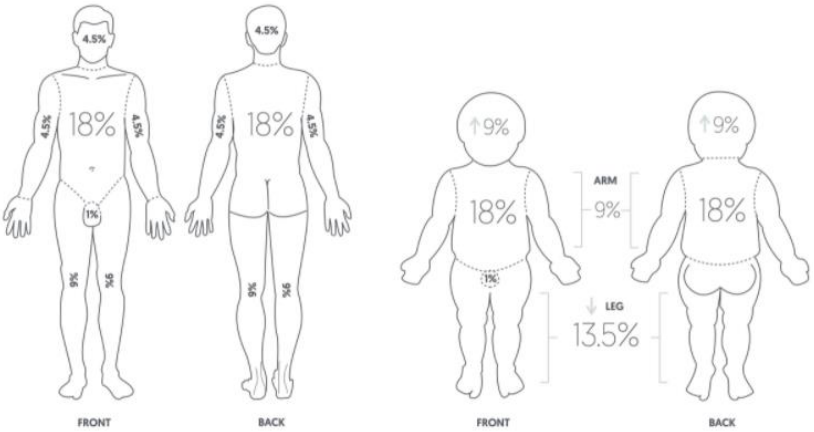
Figure 1. Wallace “rule of nines” for adults and children [17]. With permission from Pulsenotes. The rule of nines can be modified based on body mass index and age [18,19]. In 1968, Baxter and Shires formulated a measure of fluid volume requirement by weight and percentage of the TBSA, known as the Parkland formula [20,21]. During the 1960s, researchers at the Brooke and Parkland hospitals in Texas developed formulas that only used lactated Ringer’s (LR) solution, and no plasma, for the first 24 h following burn injury [21]. The modified Brooke formula (which estimates the first 24 h volume as LR solution, 2 mL/kg/total body surface area burned (TBSA), with half of this delivered over the first 8 h) and the Parkland formula (similar to the Brooke formula but 4 mL/kg/TBSA) are the most commonly used formulas for resuscitation of adult burn patients today [22]. Albumin replaced plasma in most resuscitation regimens and was primarily used during the second 24 h, at a dose of 0.3 to 0.5 mL/kg/TBSA for the day [22]. However, recent data suggest that the formula does not accurately predict fluid requirements in patients with large burns and that patients recently treated using the formula frequently required higher volumes of fluid than was predicted [23,24]. Blumetti et al. reported that only 14% of adequately resuscitated and 12% of over-resuscitated patients met the Parkland formula criteria in a retrospective study of patients resuscitated using the formula over a 15-year period [25]. Daniel et al. reported that a restrictive fluid regimen showed a higher survival rate than the liberal Parkland regimen based on data from the German burn registry [26]. Fluid resuscitation formulae are only guides to assist in the estimation of fluid requirements. Therefore, the volume of fluid should be customized for each patient according to the extent of burn injury and patient condition [27]. Regardless of the formula or strategy used, frequent adjustments based on clinical indicators of the adequacy of resuscitation are required in the first 24–48 h (Table 1) [27].